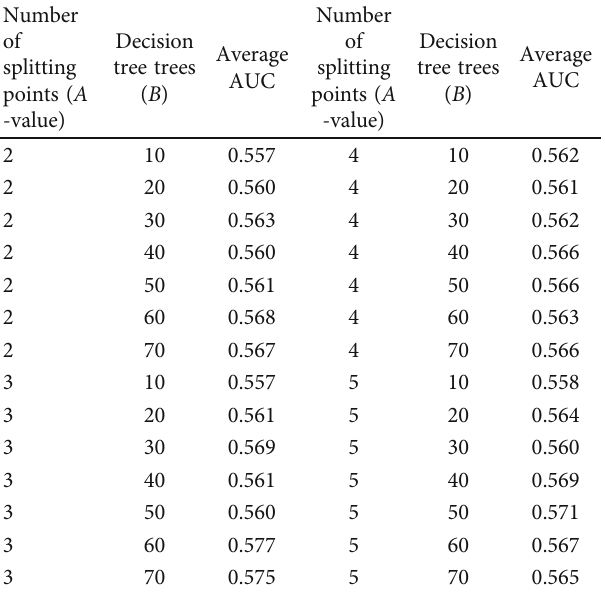
Table 11: Mean AUC test results for di ff erent parameter